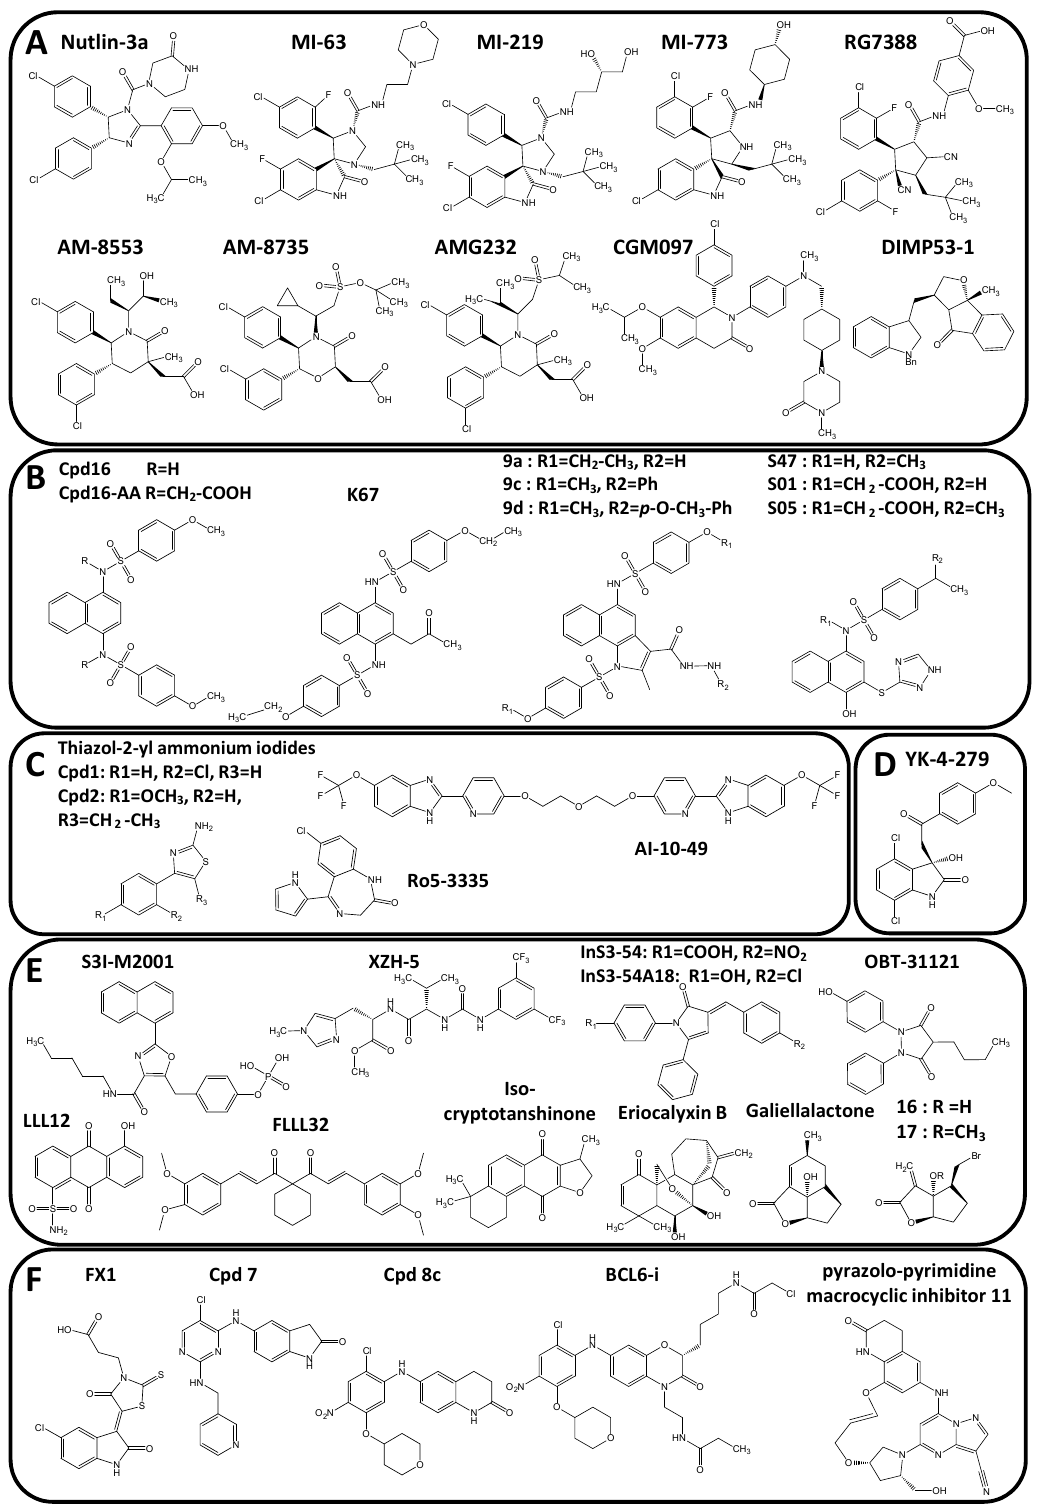
Figure 4. Targeting transcription factor at the protein/protein interaction level. ( A ) p53/mdm2 PPIi; ( B ) Keap1/Nrf2 PPIi; ( C ) RUNX1/CBF β PPIi; ( D ) Ets transcription factors/RNA helicase A PPIi; ( E ) STAT3 PPIi; ( F ) BCL6 PPIi.